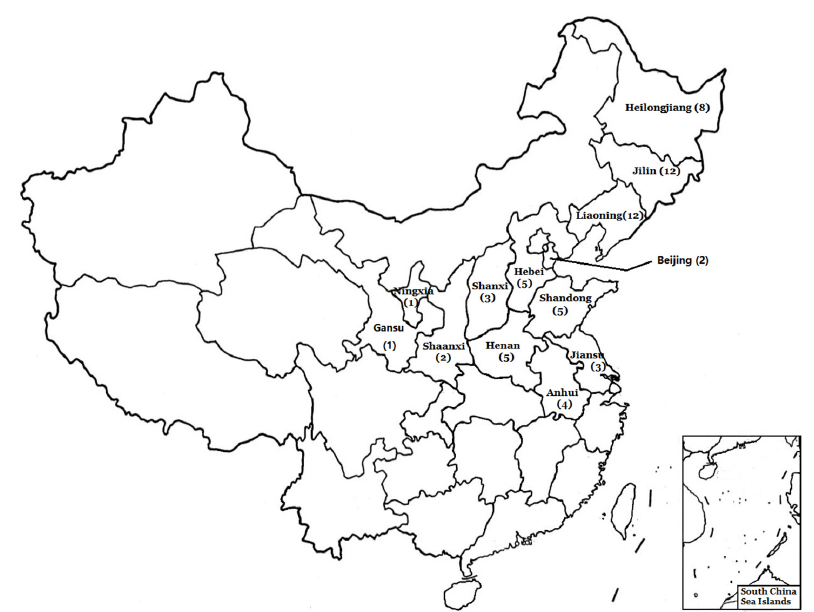
Figure 1. Distribution of sampling locations. The numbers in parentheses indicate the sample size of each province.